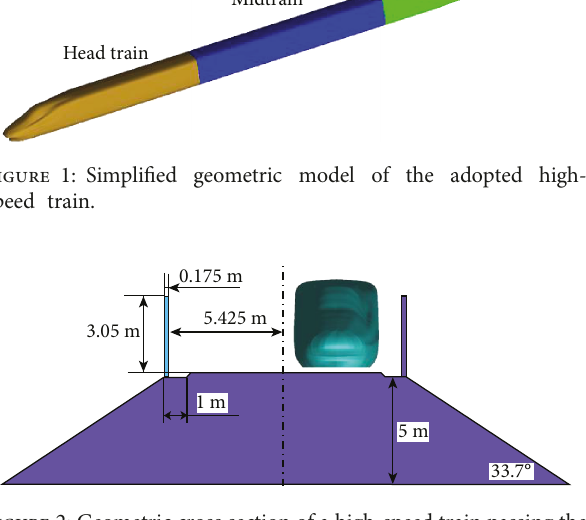
Figure 2: Geometric cross section of a high-speed train passing the embankment air